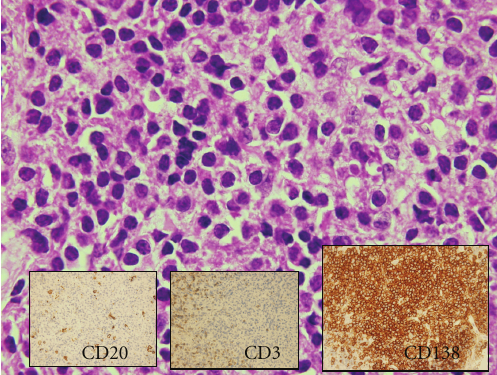
Figure 2: Neoplastic proliferation of di ff erentiated plasma cells. Immunochemistry was positive for CD138 (plasma cell marker) and negative for CD20 (accompanying B-lymphocytes) and CD3 (accompanying